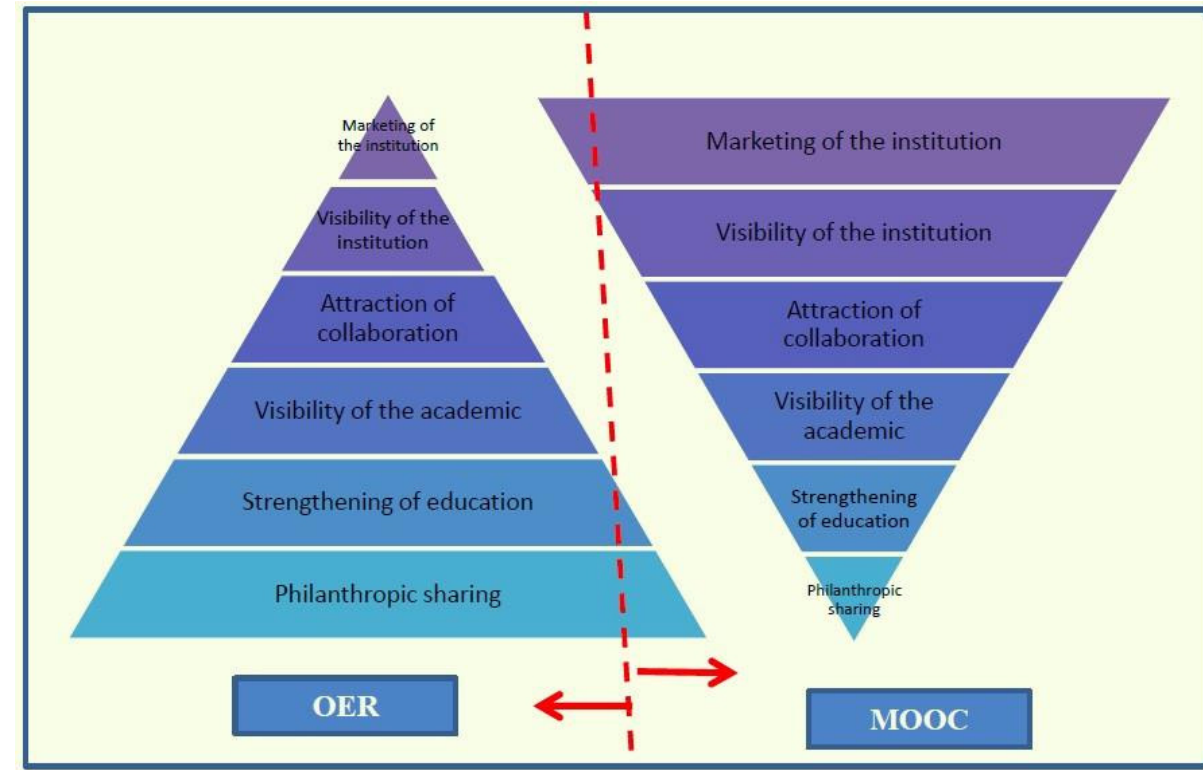
Figure 4. Comparison of fundamental purposes of OERs and